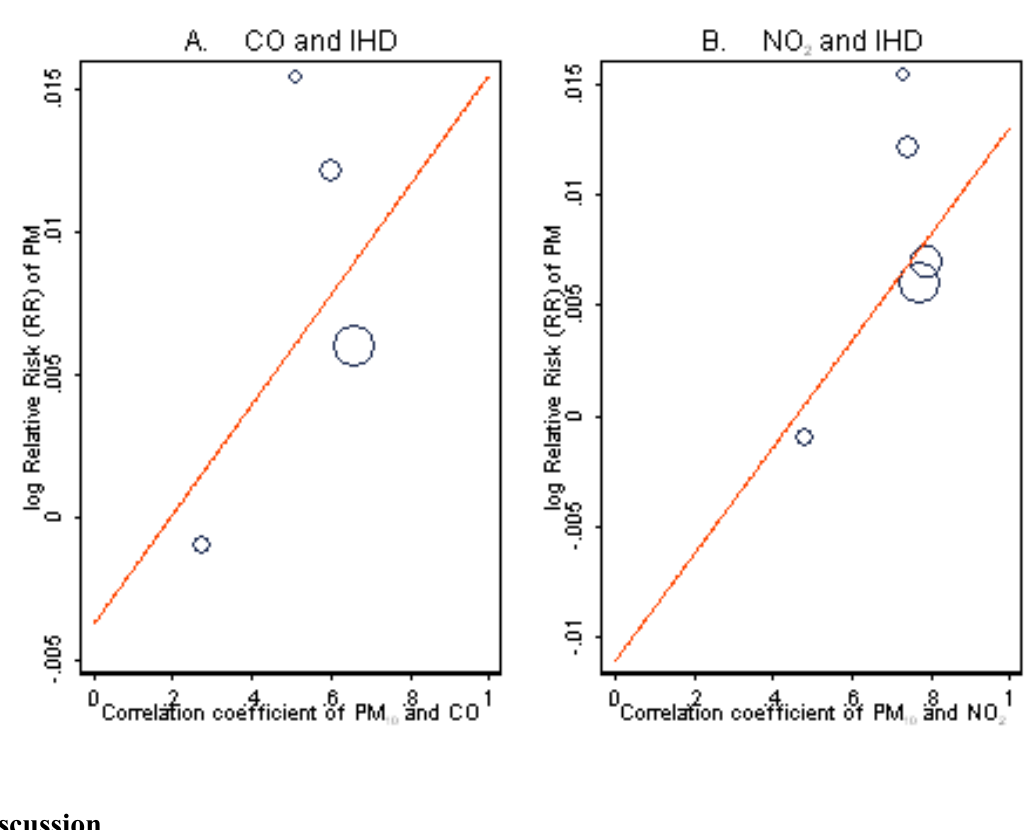
Figure 5. Univariate relationship between the log relative risk (RR) of hospitalization for IHD in association with exposure to CO ( A ) and NO with PM 10